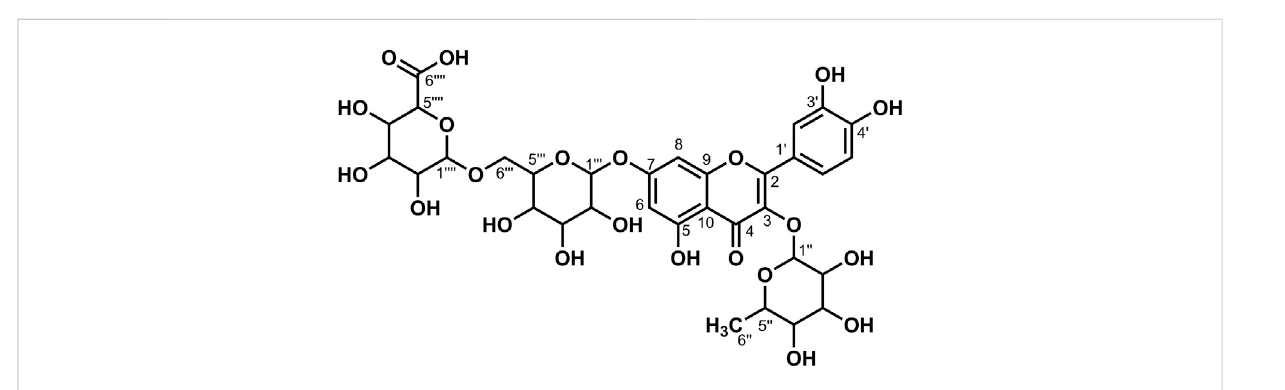
FIGURE 9 Chemical structure of compound 13